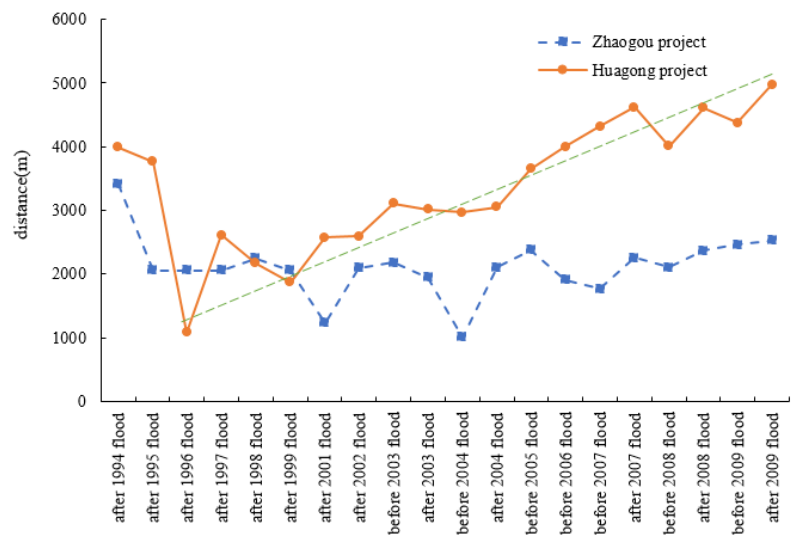
Figure 6. Changing distance of the site where the main flow is close to the project at Zhaogou- Huagong project reach.